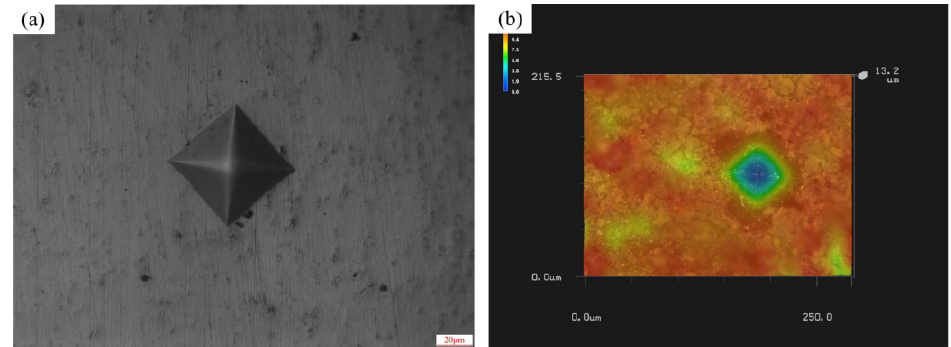
Figure 4. Tungsten alloy indentation; ( a ) indentation morphology before ablation; ( b ) indentation morphology after ablation.